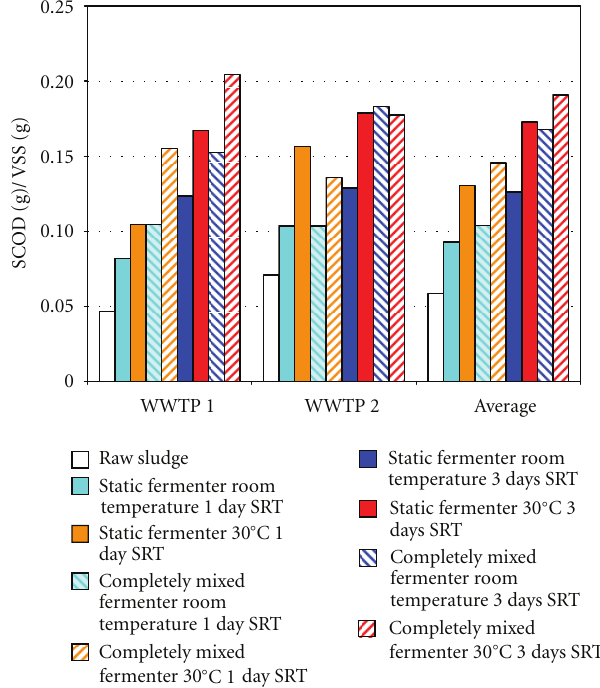
Figure 4: Specific SCOD production for WWTP 1, WWTP 2, and specific SCOD production total